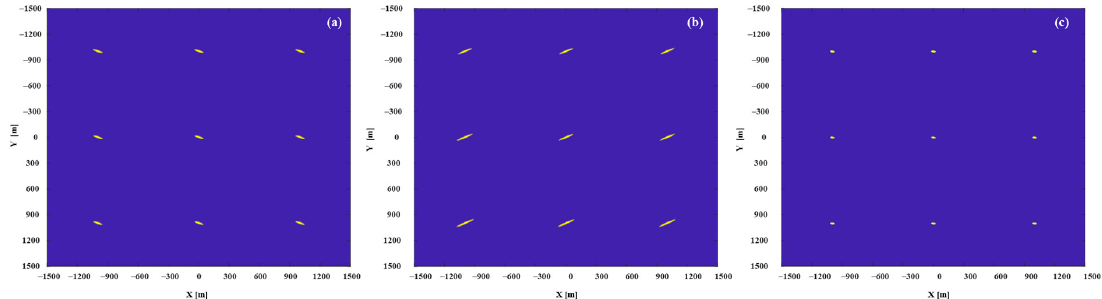
Figure 13. The 2-D resolution units: ( a ) is the 2-D resolution units of PRN21, ( b ) is the 2-D resolution units of PRN10, and ( c ) is the fusion 2-D resolution units of PRN21 and PRN10.